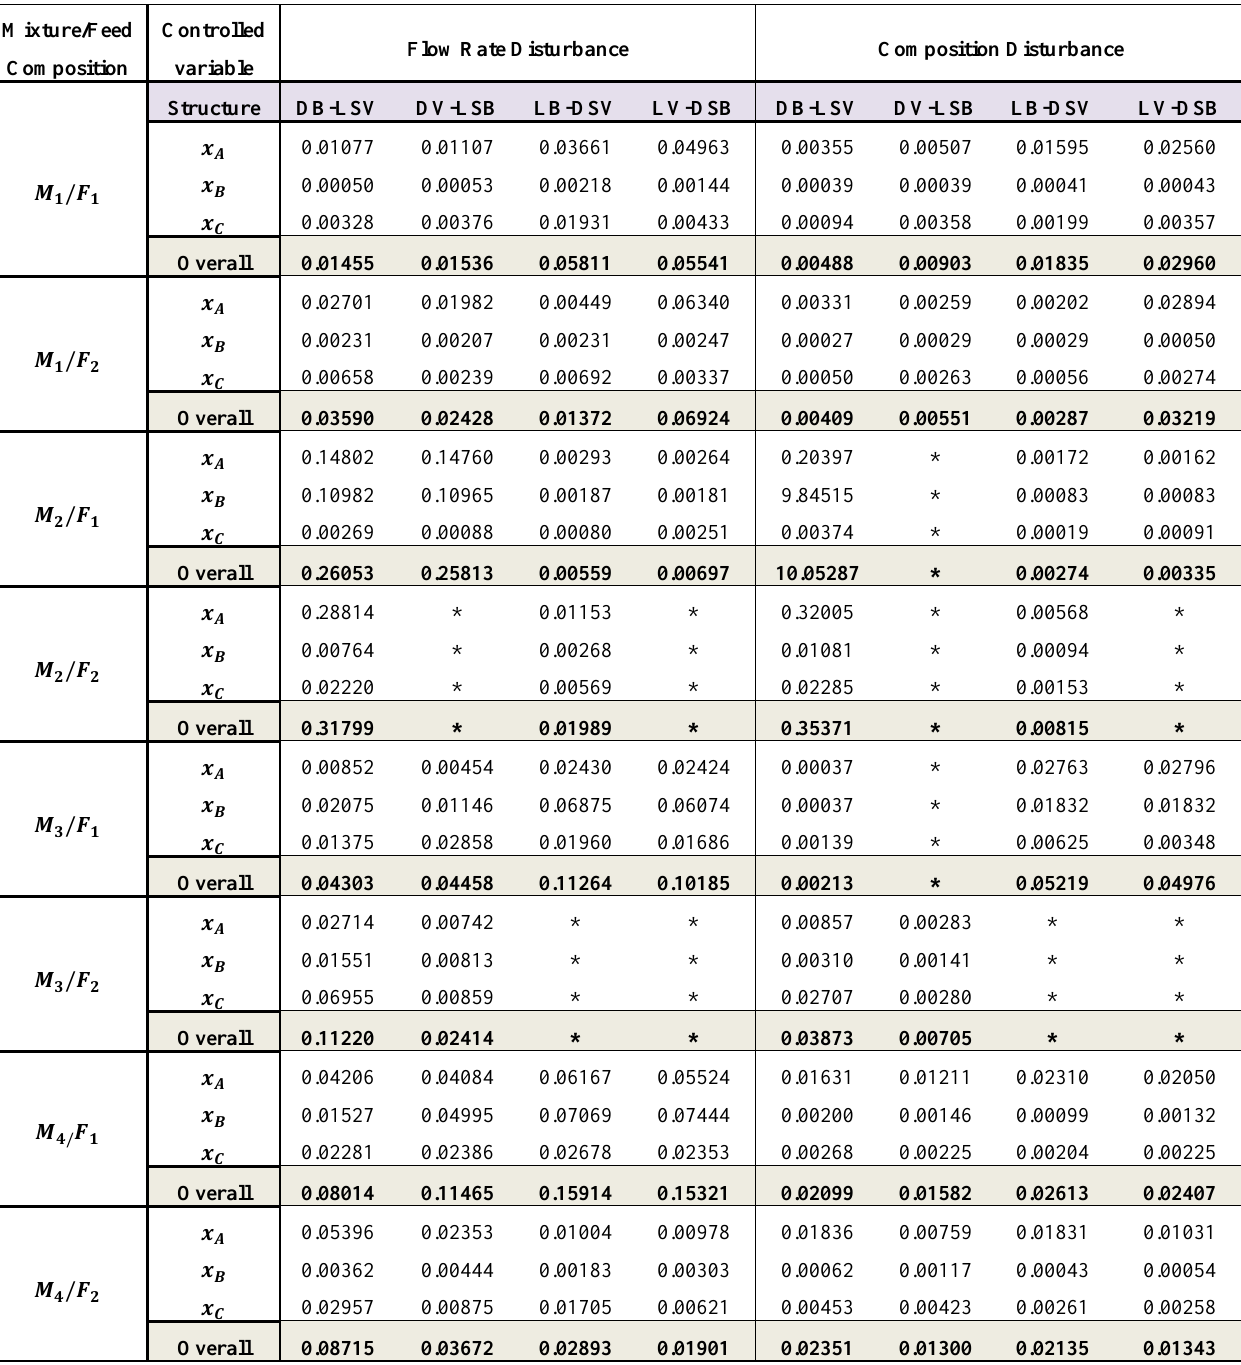
Table 7. Integral of Absolute Error (IAE) values for all case